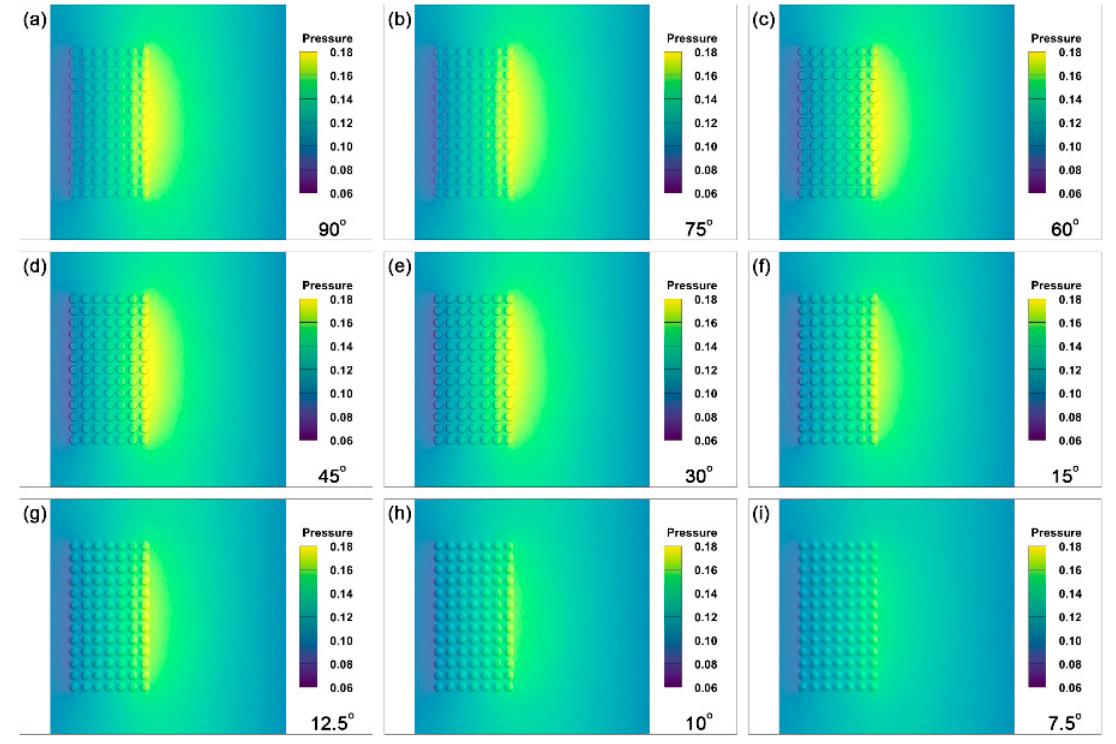
Figure 10. Pressure distributions on the bottom surface of the model for dimple surface angle 90° ( a ), 75° ( b ), 60° ( c ), 45° ( d ), 30° ( e ), 15° ( f ), 12.5° ( g ), 10° ( h ) and 7.5° ( i ).